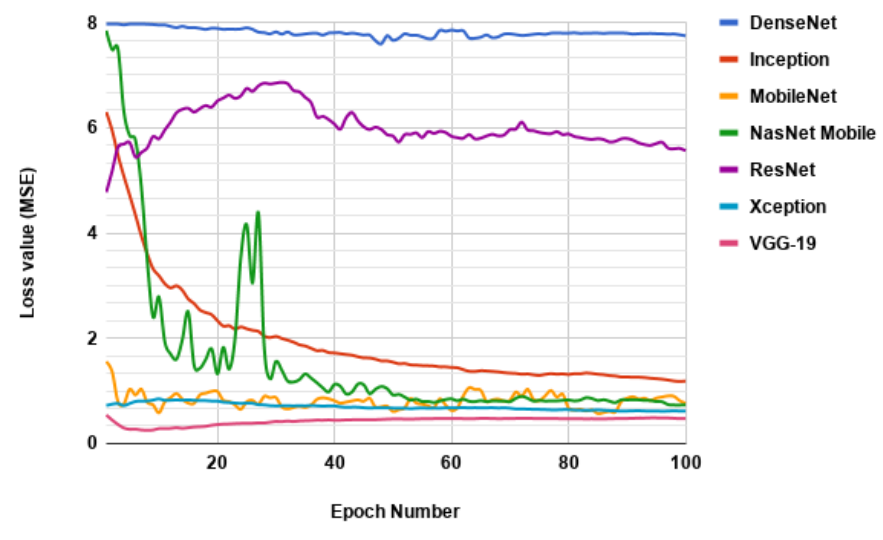
Figure 16. Training of above mentioned networks are shown. The upper figure compares various existing unique architectures for the purpose of transfer learning in our context. The lower figure compares their MSE loss. An interesting relationship between the depth of the networks and their accuracy is observed. Comparatively shallow networks are more likely to perform better in our scenario.